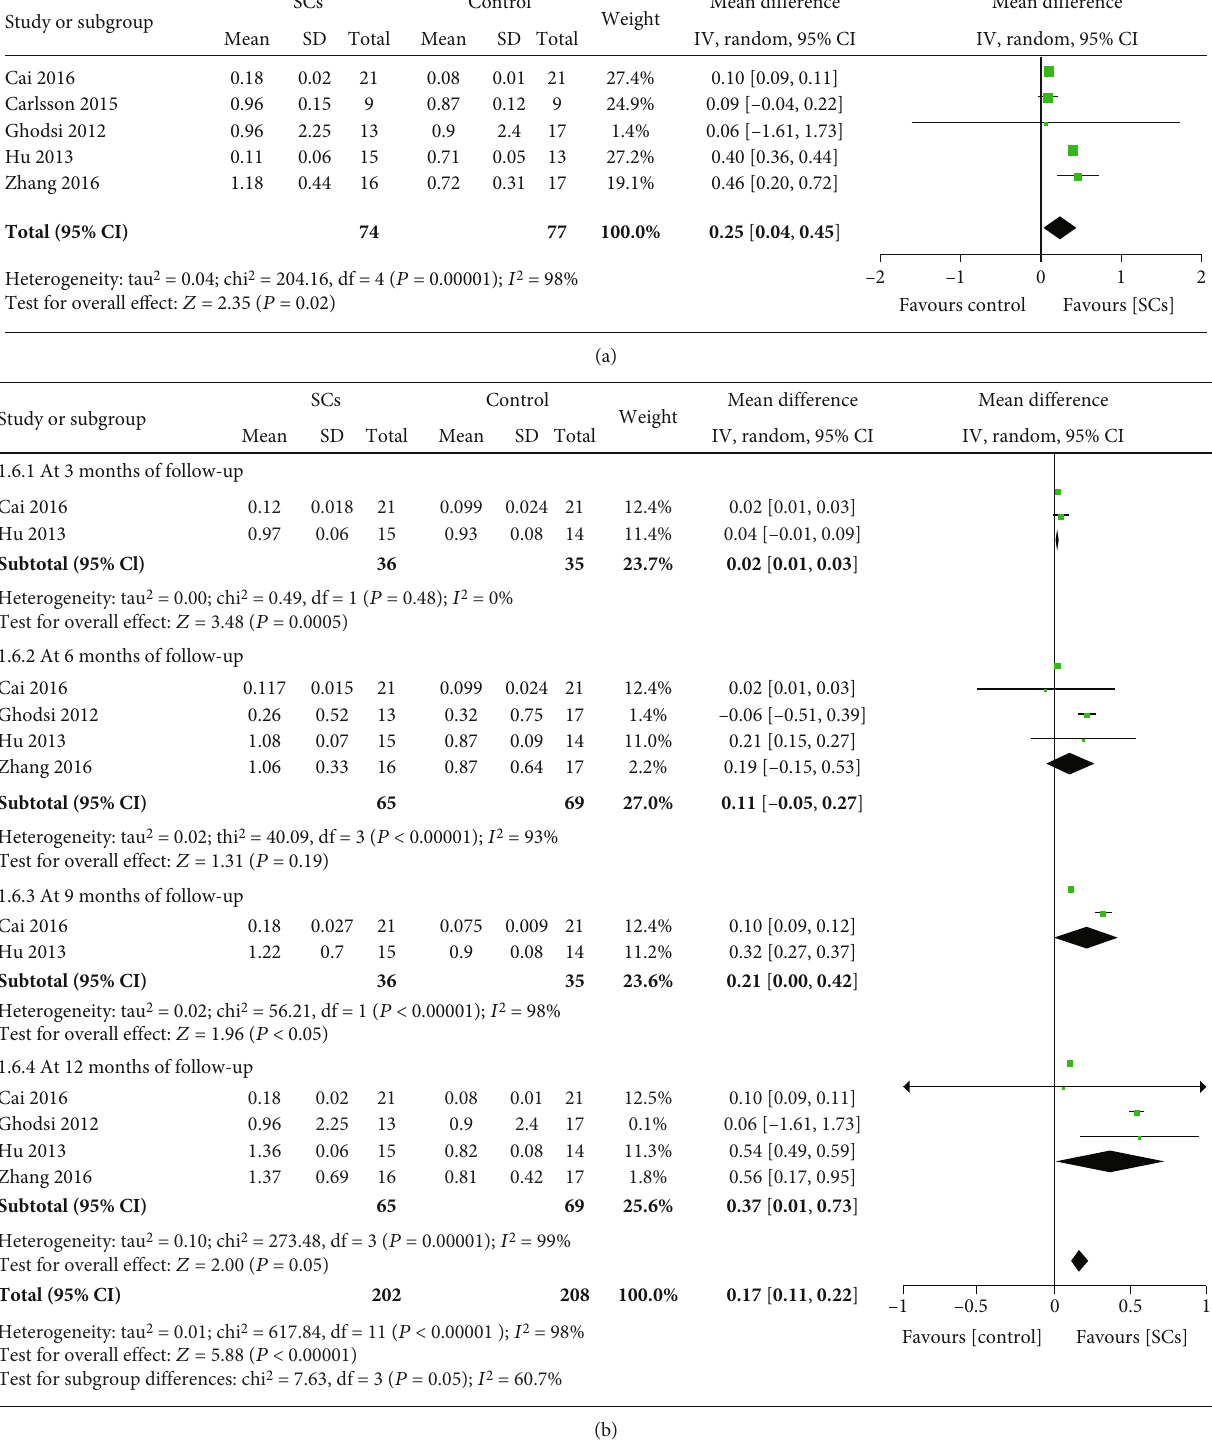
Figure 4: Fasting C-peptide at the longest follow-up (a). Fasting C-peptide at di ff erent follow-up (b)